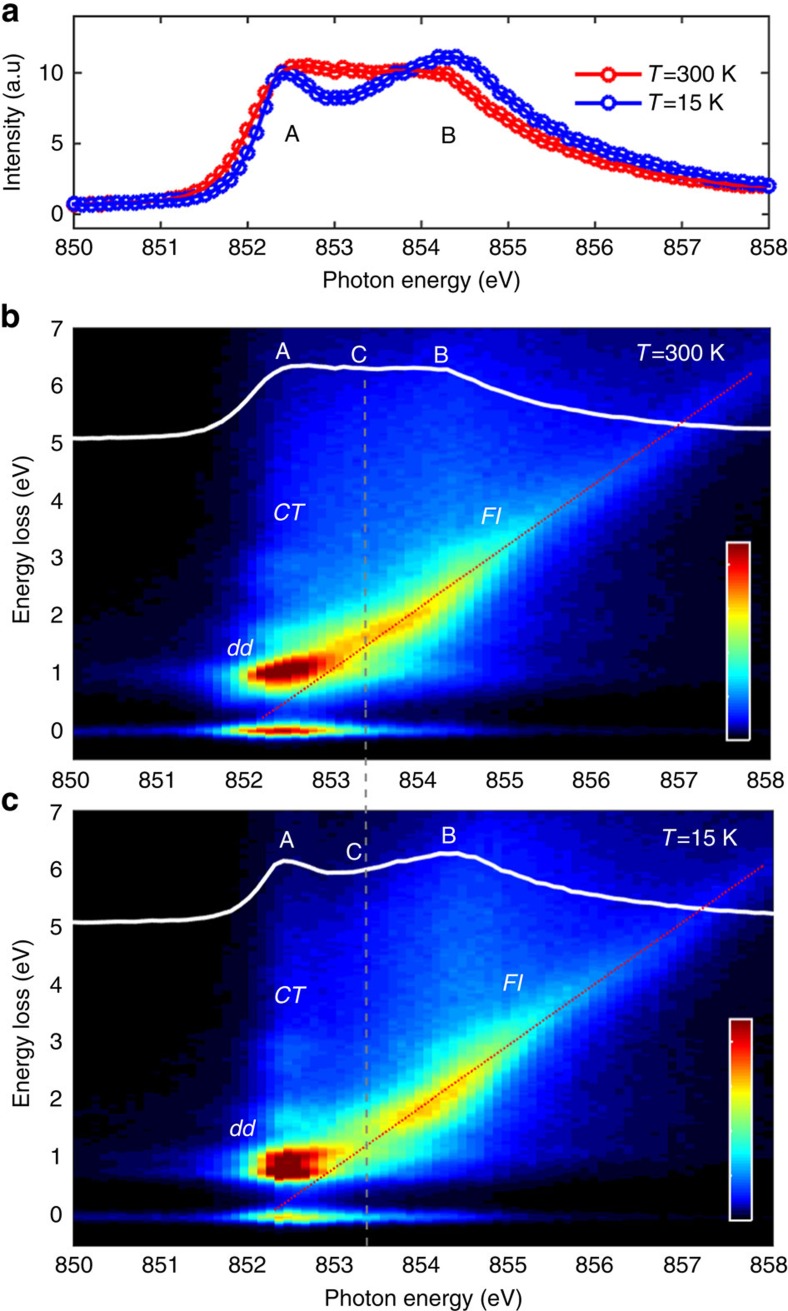
Overview of XAS and RIXS measurements for a 30 nm NdNiO3 film on NdGdO3.(a) Ni L3,2 XAS measured in partial fluorescence yield mode at 300 K (metallic phase) in red and at 15 K (insulating phase) in blue. Refer to Supplementary Note 2 and Supplementary Fig. 2 for XAS in total electron yield mode. (b,c) RIXS intensity map measured across the Ni L3 edge at 300 K (15 K); intensity scale bar from 0 to 5 (a.u.). The white solid line displays the XAS measured at the same temperature. The letters A, B and C mark the three different incident energies mentioned in the text, while dd, CT and Fl refer to RIXS excitations of different character, also discussed in the text. The grey-dashed line indicates the incident energy giving the most pronounced changes in the RIXS map and in the XAS across the MIT. The red-dotted line provides a guide to the eye for the linearly energy dispersing Fl feature.